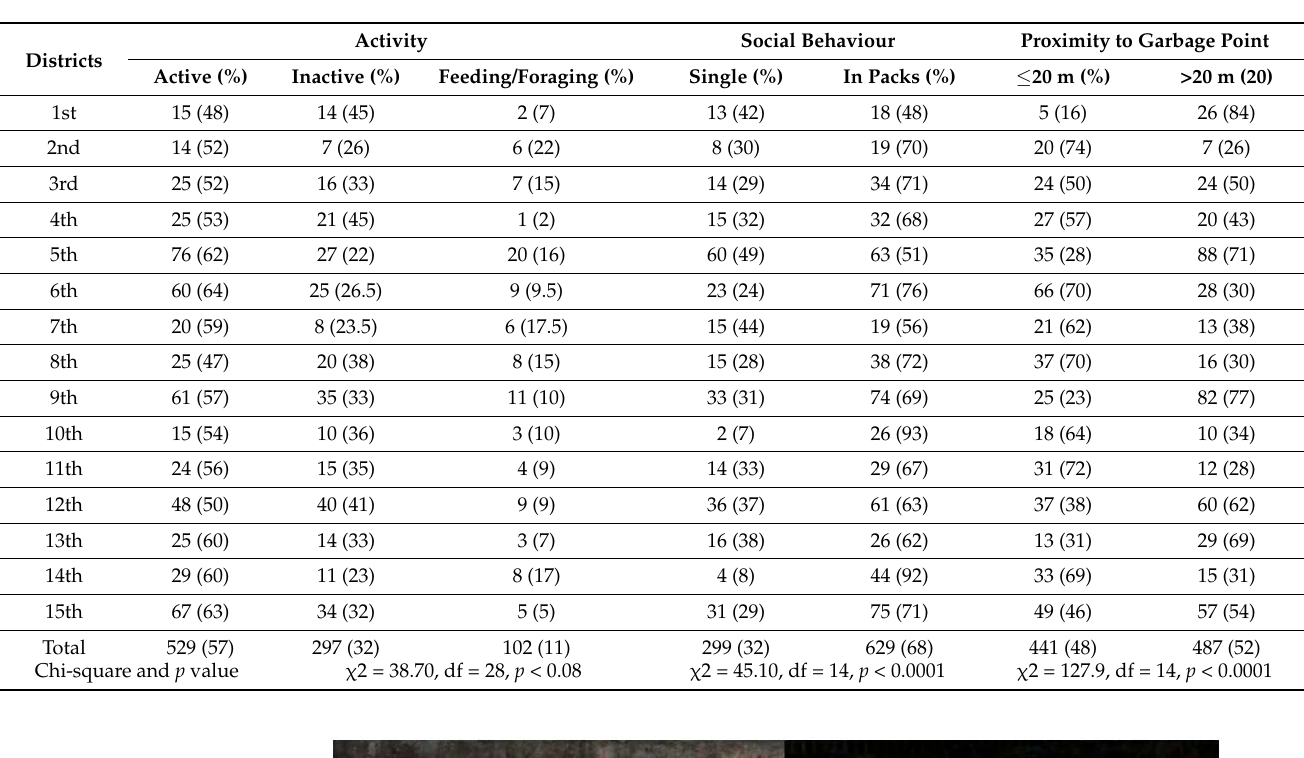
Table 4. Details of activity, social behaviour and sightings within 20 m of garbage points for FRDs sighted across fifteen districts of Herat city.